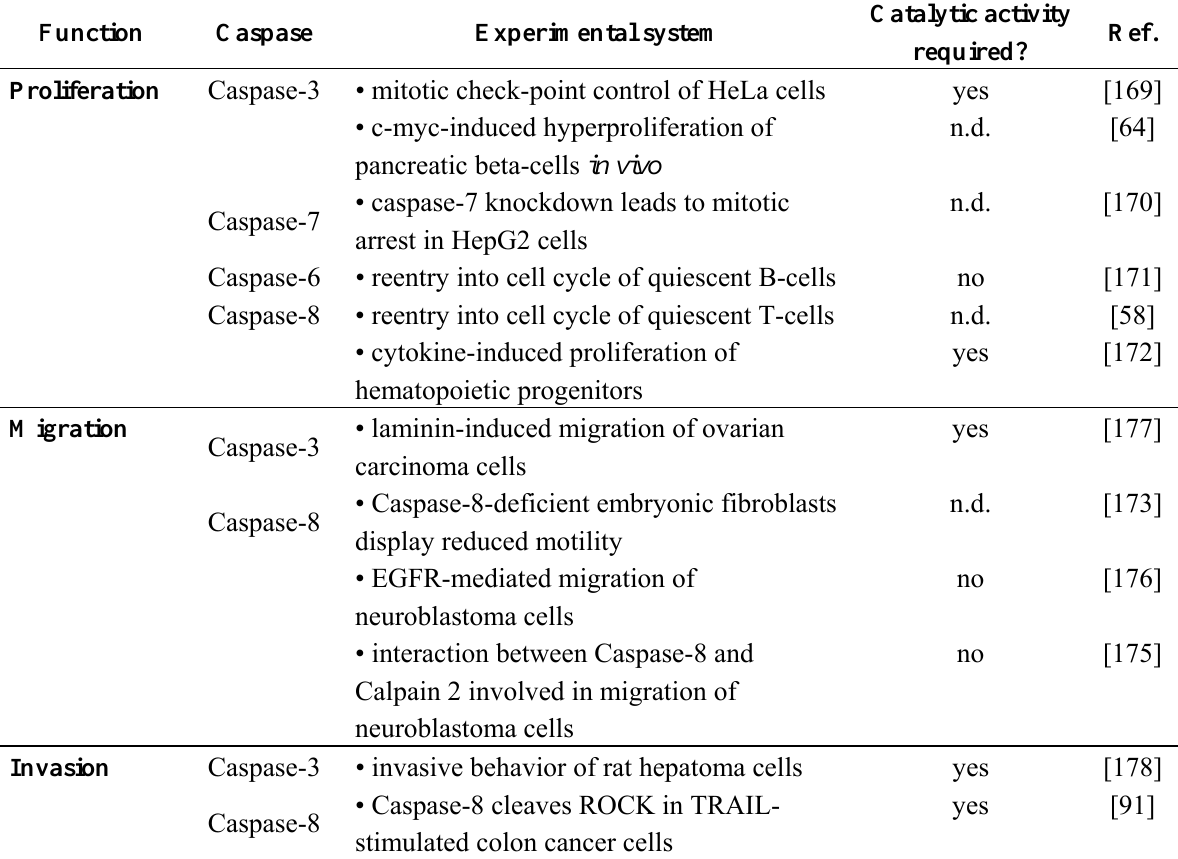
Table 2. Non-apoptotic functions of caspases which might play a role in tumorigenesis. (n.d., not determined; Ref.,